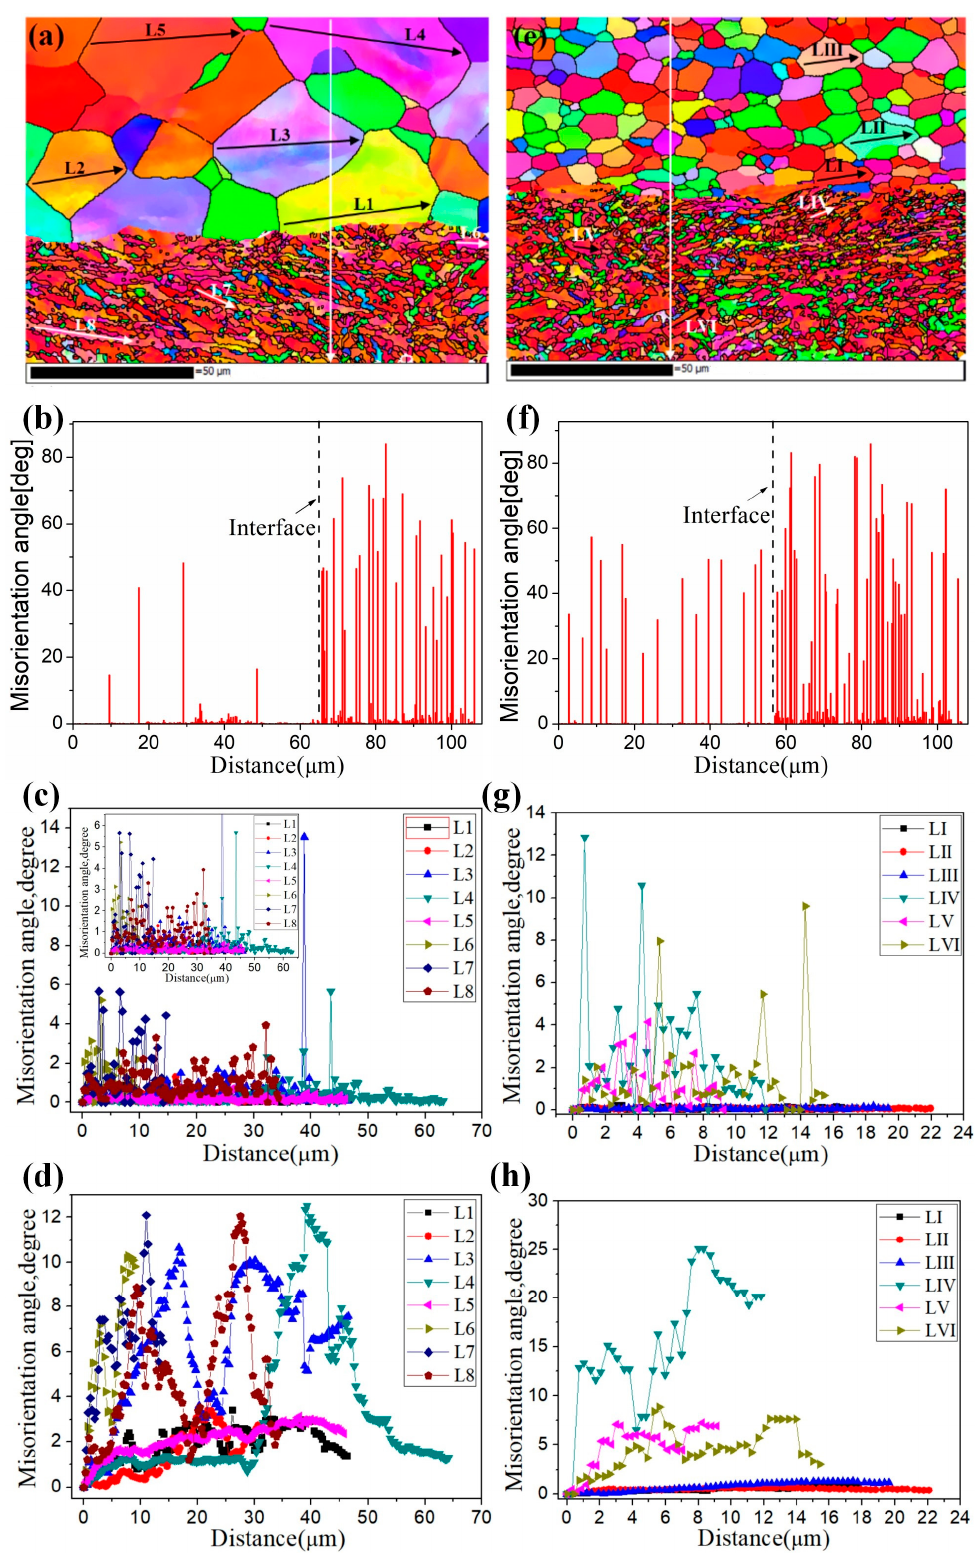
Figure 21. Relative misorientation profiles (( b , f )) along the vertical lines under different initial strengths of aluminium. ( a ) Specimen B3; ( e ) specimen C3; ( c ) and ( g ) point-to-point misorientation along L1–L8 and LI–LVI; ( d , h ) point-to-origin misorientation along L1–L8 and LI–LVI. Figure 22 shows the kernel average misorientation (KAM) near the interface under different initial strengths of aluminium. The green area has high residual strain, and the